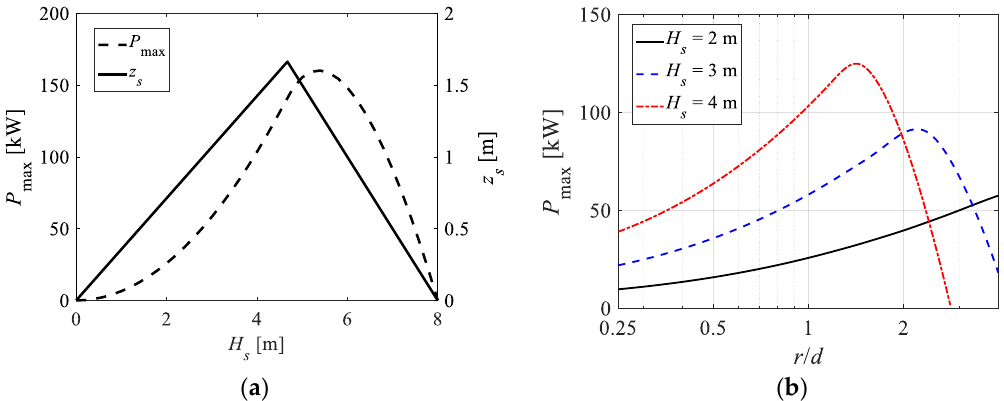
Figure 7. ( a ) An example of the maximum absorbed power P max and the corresponding significant motion amplitude z s as functions of the significant wave height H s for a vertical truncated cylindrical buoy with the radius-to-draft ratio of r / d = 1 at the sea state of T e = 8 s. ( b ) The maximum absorbed power as a function of the radius-to-draft ratio at the sea state of T e = 8 s.